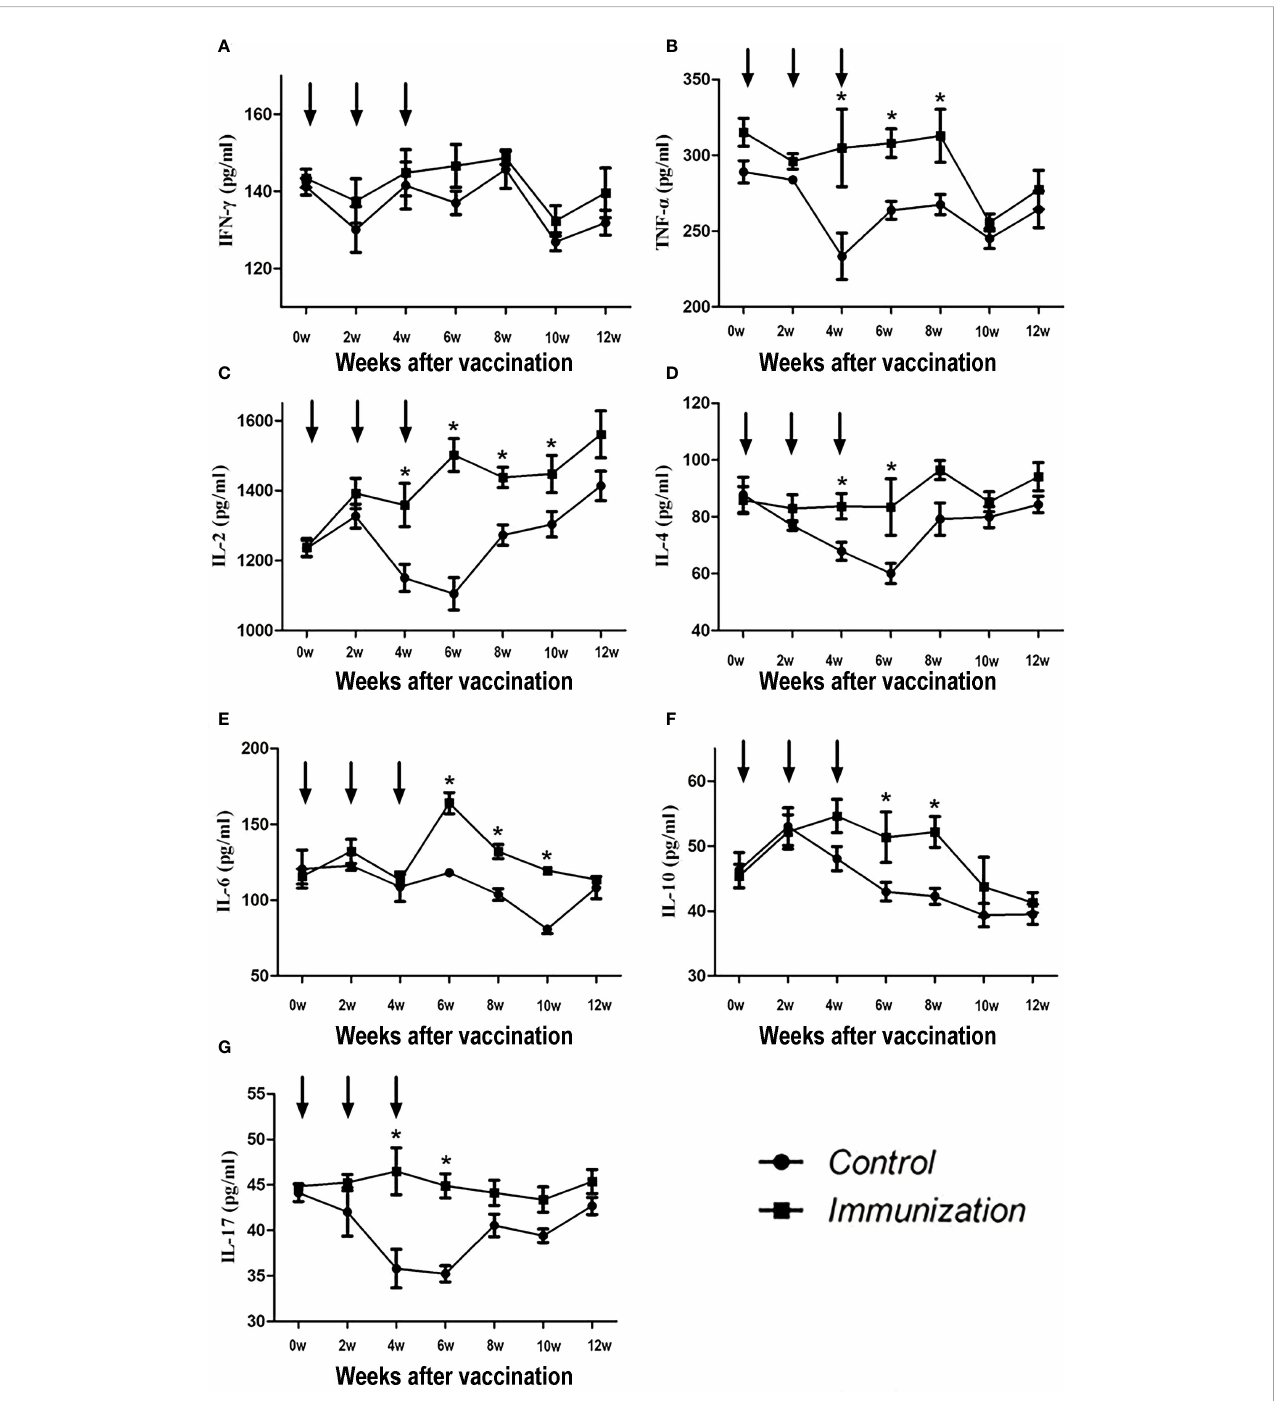
FIGURE 3 Mean (± SEM) of the serum IFN- g (A) , TNF- a (B) , IL-2 (C) , IL-4 (D) , IL-6 (E) , IL-10 (F) , and IL-17 (G) concentrations in the gonadotropin-releasing hormone (GnRH) immunization group (n = 35) and control group (n = 35). All were detected using enzyme-linked immunosorbent assays (ELISAs). The ordinate is the concentration of immue cytokine. The abscissa is the age of weeks after fi rst immunization and arrows indicate the primary vaccination and subsequent boosters. * Indicates a signi fi cant difference ( P